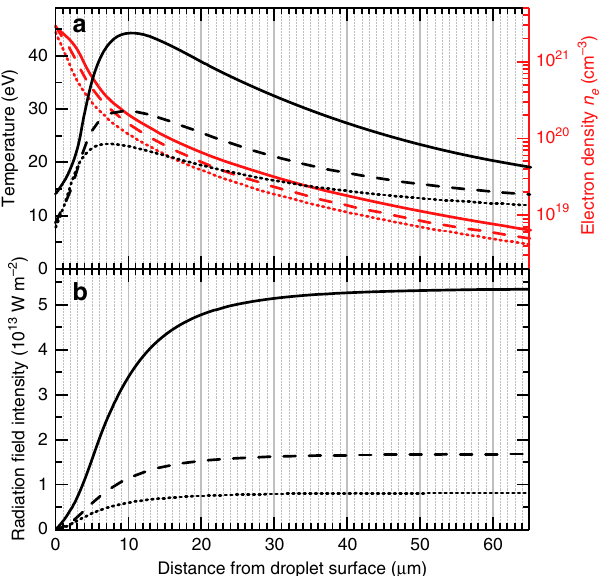
Fig. 6 Simulation results. a Temperature and density pro fi les calculated by RALEF-2D simulations for laser intensities of 0.4 (dotted), 0.7 (dashed) and 1.4 (solid) × 10 11 W cm − 2 , respectively. b Radiation fi eld intensity obtained by solving the simpli fi ed frequency-integrated transport equation, from Eq. (4), along the density and temperature pro fi les in a